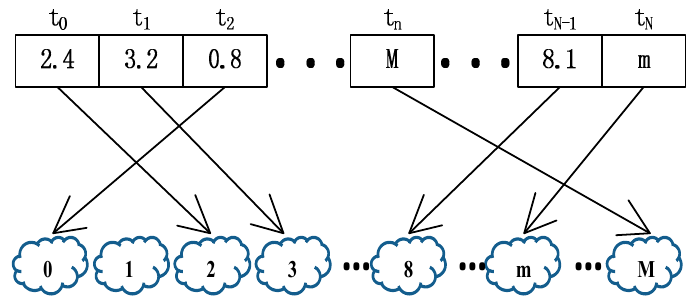
Figure 2. An encoding example of the computation offloading for the computing tasks.